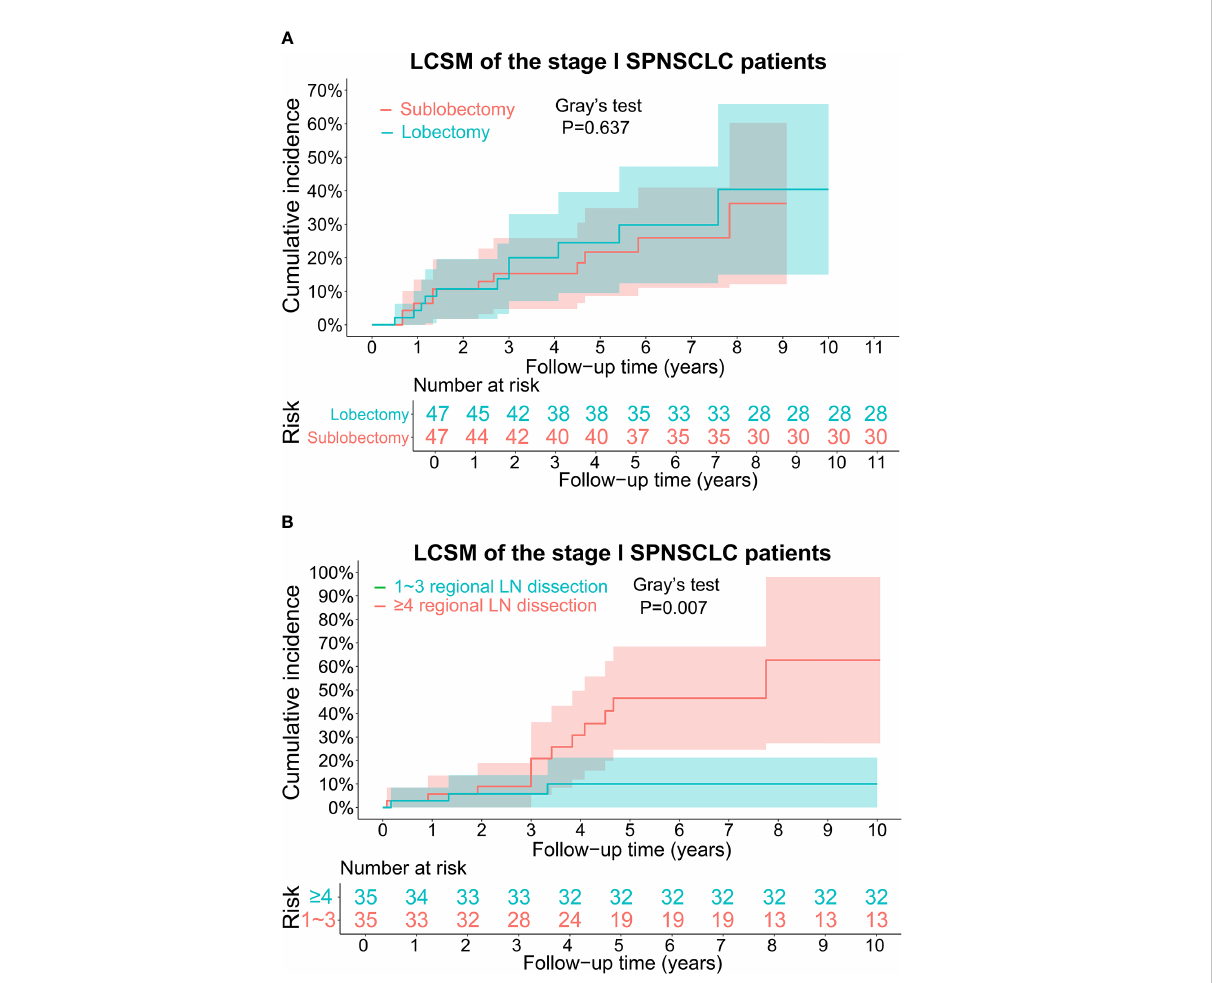
FIGURE 4 (A) CIF curves for estimating the LCSM in the stage I SP cohort after propensity score matching, and the differences in CIF between the patients undergoing sublobectomy and patients undergoing lobectomy. The number of patients at risk was listed under the fi gure, and the shaded bands represented the 95% con fi dence intervals. P-value of difference in CIF was determined based on Gray ’ s test. (B) CIF curves for estimating the LCSM in the stage I SP cohort after propensity score matching, and the differences in CIF between the patients undergoing 1~3 regional LN dissection and patients undergoing ≥ 4 regional LN dissection. The number of patients at risk was listed under the fi gure, and the shaded bands represented the 95% con fi dence intervals. P-value of difference in CIF was determined based on Gray ’ s test. CIF, cumulative incidence function, LCSM, lung cancer- speci fi c morality; LN, lymph node; SP, second primary non-small cell lung